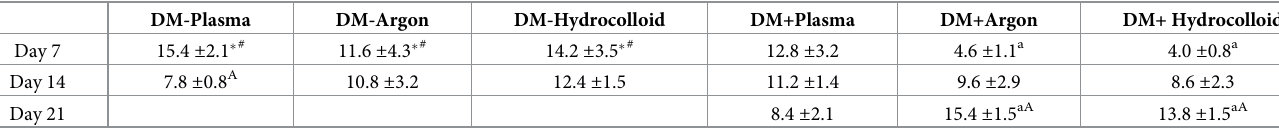
Table 3. Number of new blood vessels.